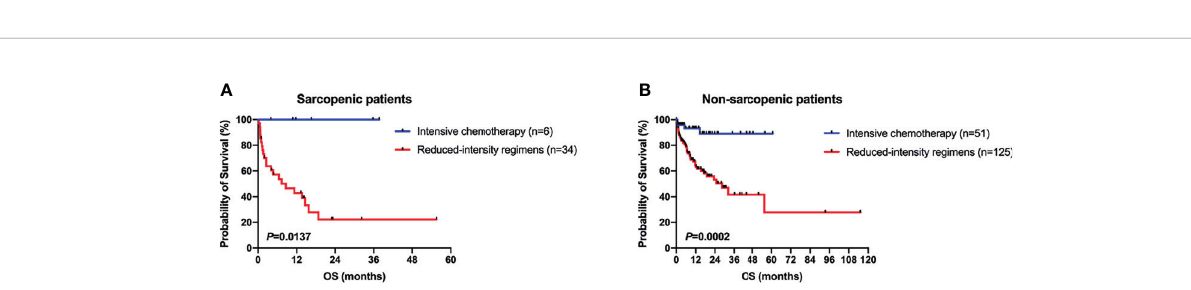
FIGURE 3 | Survival curves of patients strati fi ed by 2017 ELN risk strati fi cation. (A) OS curves of all patients were signi fi cantly separated according to the ELN risks ( P = 0.0052). (B) OS curves of patients ≥ 60 years old were signi fi cantly separated according to the ELN risks ( P = 0.0379). ELN, European Leukemia